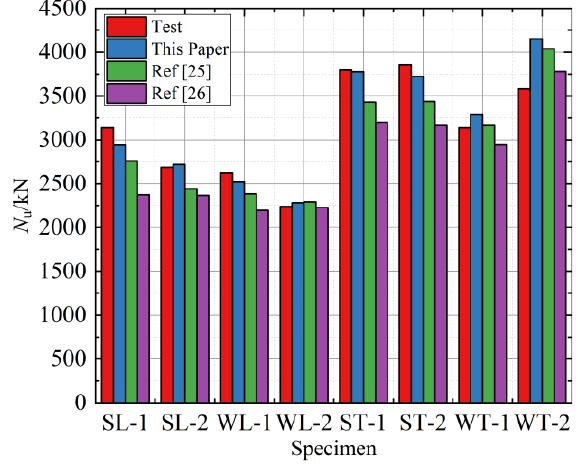
Figure 21. Ultimate bearing capacity comparison between test results and FEAs.